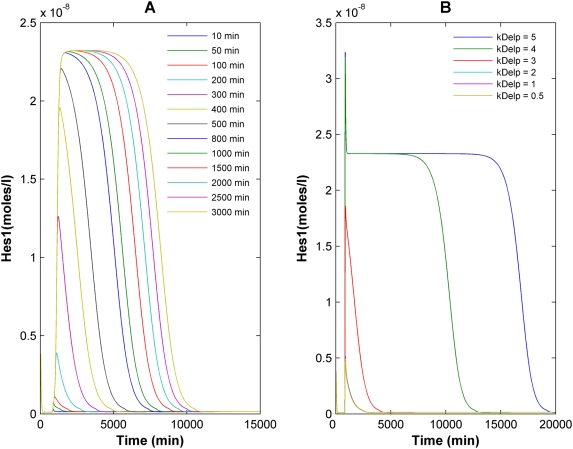
Both input Delta signal strength and duration affect the output Hes1 expression levels.(A) Effect of Delta signal duration on the Hes1 expression levels: a transient Delta signal of kfNcp*Delp = 5×10−3 was provided in the deterministic model for varying amounts of time ranging from 10 minutes to 3000 minutes, and the resulting Hes1 trajectories were simulated up to 15000 minutes. (B) The effect of Delta signal strength on Hes1 expression: a transient Delta signal of varying strengths (expressed as kDelp = kfNcp*Delp (min−1)) was provided in the deterministic model for 100 minutes, and the resulting Hes1 were simulated up to 20000 minutes.